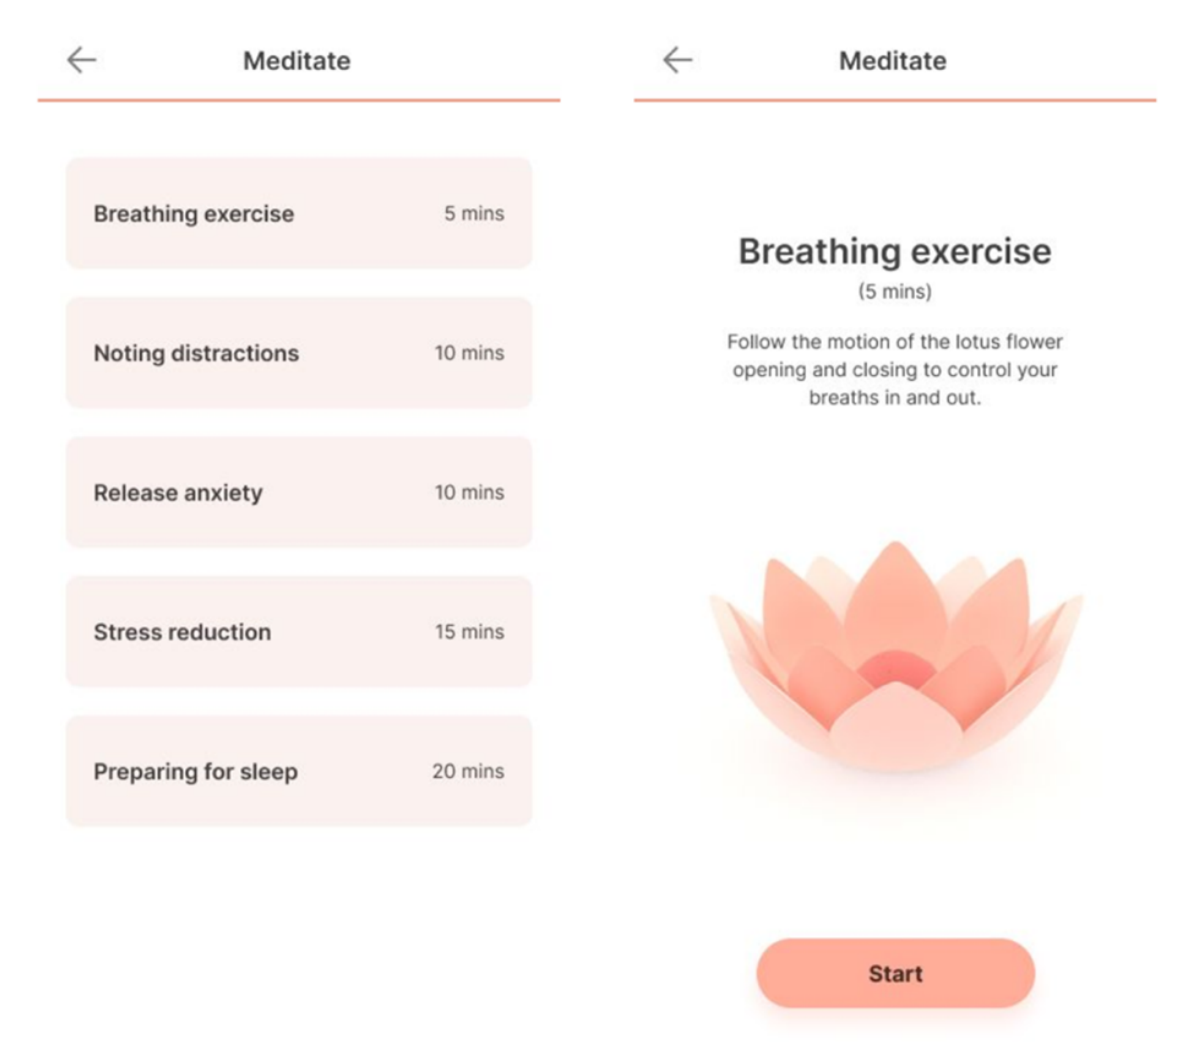
Figure 9. Example of one of the guided mindfulness exercises offered in